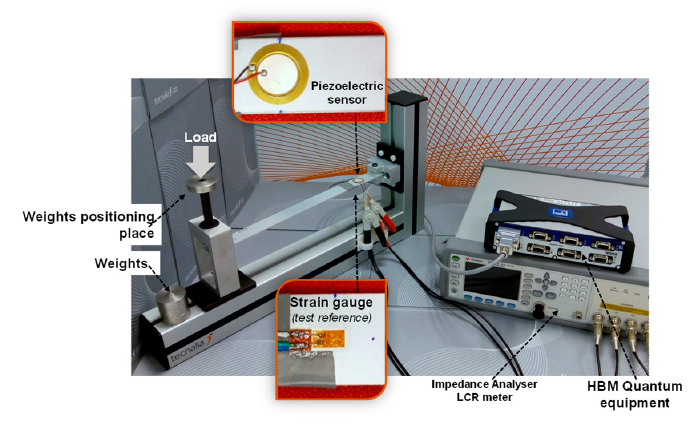
Figure 2. Test setup and measurement equipment.